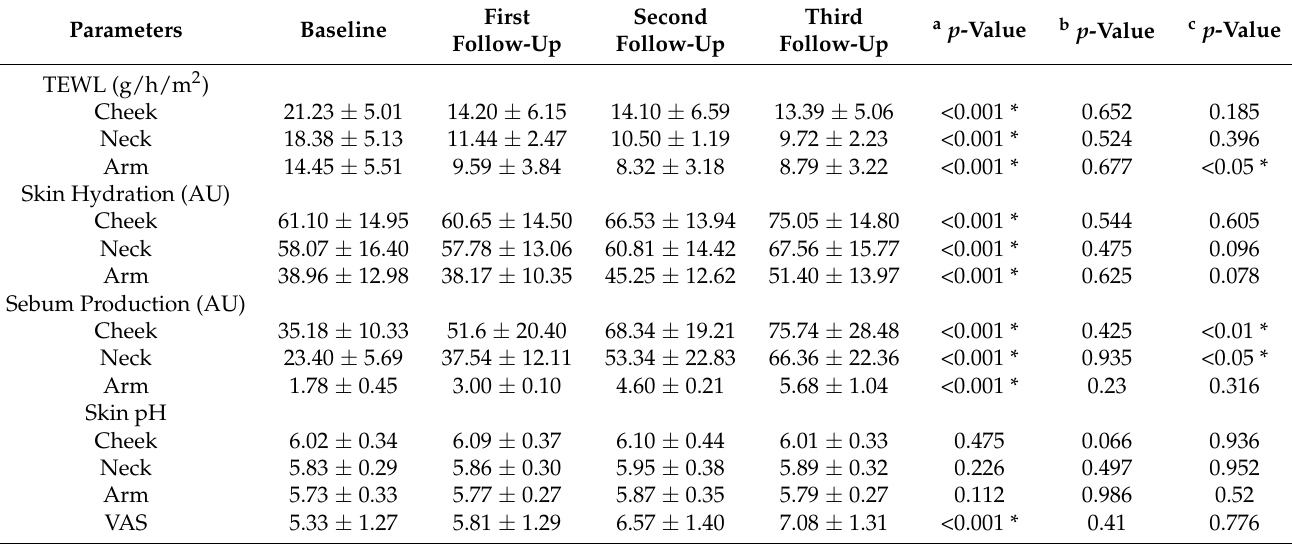
Table 2. Changes in skin barrier function of participants during